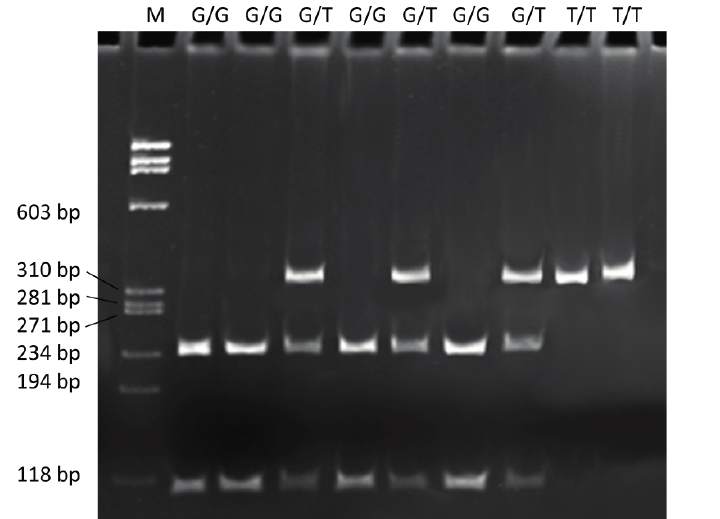
Figure 2. Restriction fragment length polymorphism analyses of the g.61564299G>T (rs4246215) polymorphism of FEN1 . Genotypes are indicated in the upper part of the picture. Lane M is a Φ X174 DNA/BsuRI Marker